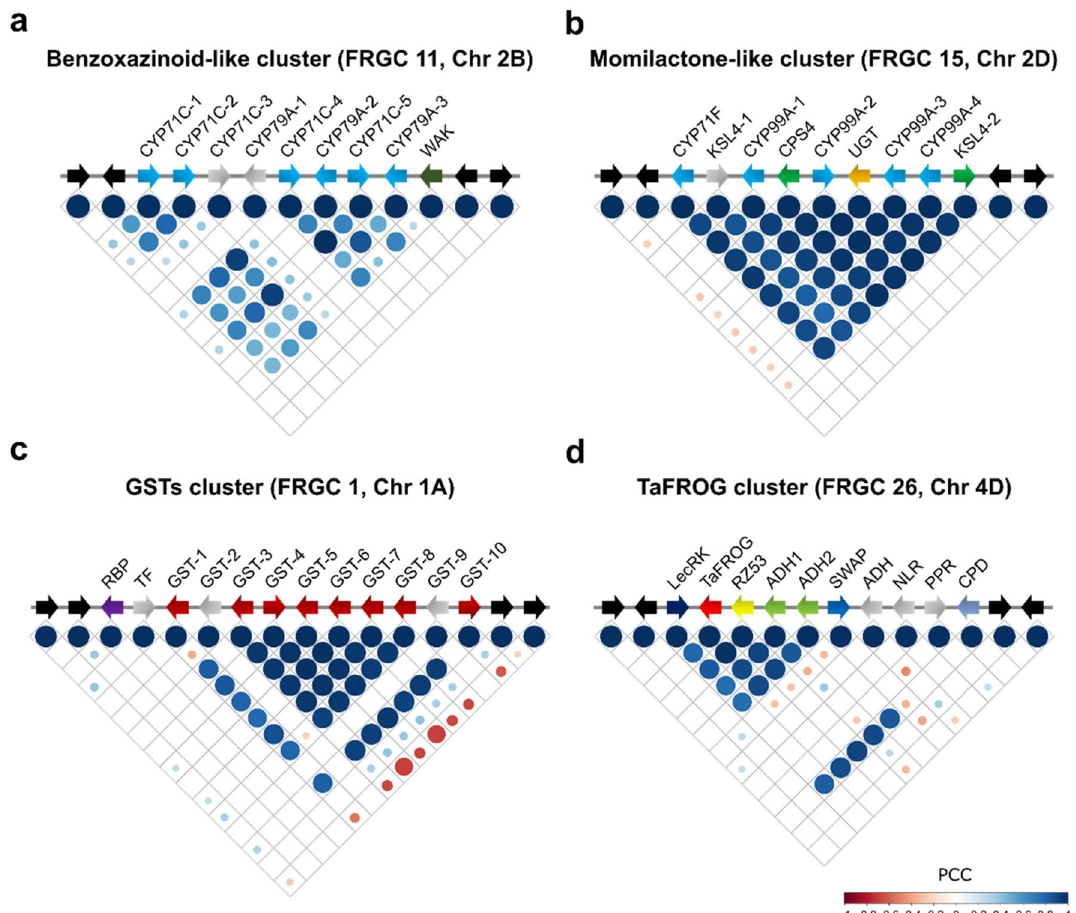
Figure 3. Content, arrangement, and co-expression profiles of representative FRGCs. Schematic representations of Fusarium -responsive gene clusters are represented as: Fusarium -responsive (coloured arrows), non-responsive genes (grey arrows) and two neighbouring genes (black arrows). Different colours indicate distinct classes of proteins. Co-expression matrices are shown below each cluster. Circle characteristics represent the direction (colour, blue = positive, red = negative) and the strength (size) of the correlation. Four examples of FRGCs are illustrated and correspond to nonhomologous metabolic (( a ) benzoxazinoid-like and ( b ) momilactone-like cluster), paralogous non-metabolic (( c ) GSTs cluster), and nonhomologous non-metabolic (( d ) TaFROG cluster) categories. FRGC ID and chromosome number are indicated between brackets. ( a ) The benzoxazinoid-like cluster contain genes coding for a wall-Associated kinase (WAK) and two class of CYP450s genes with four benzoxazinoid-like genes coding for CYP71C, and two CYP79A genes. ( b ) The momilactone- like cluster is similar to the characterised rice momilactone gene cluster 37 , with CYP450s (CYP) mono ‐ oxygenases (CYP99A2/A3), two terpene synthase kaurene synthase (KS) and copalyl diphosphate synthase (CPS) genes, but without the momilactone A synthase gene absent in the wheat cluster. ( c ) The GSTs